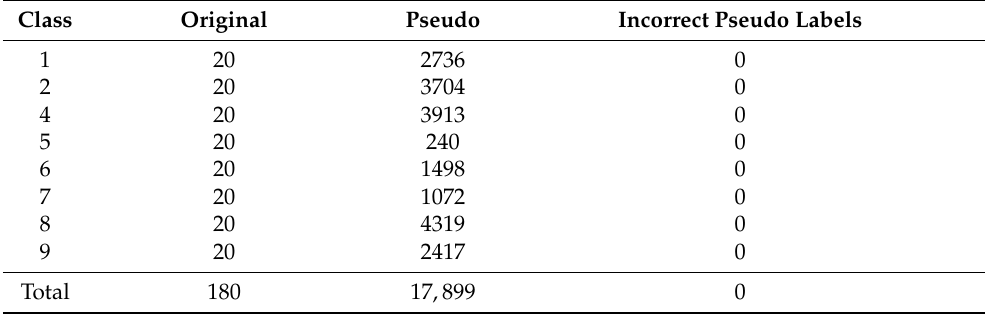
Table 4. Number of original samples, pseudo-label samples, and incorrect pseudo-label samples of each class for the University of Pavia dataset.